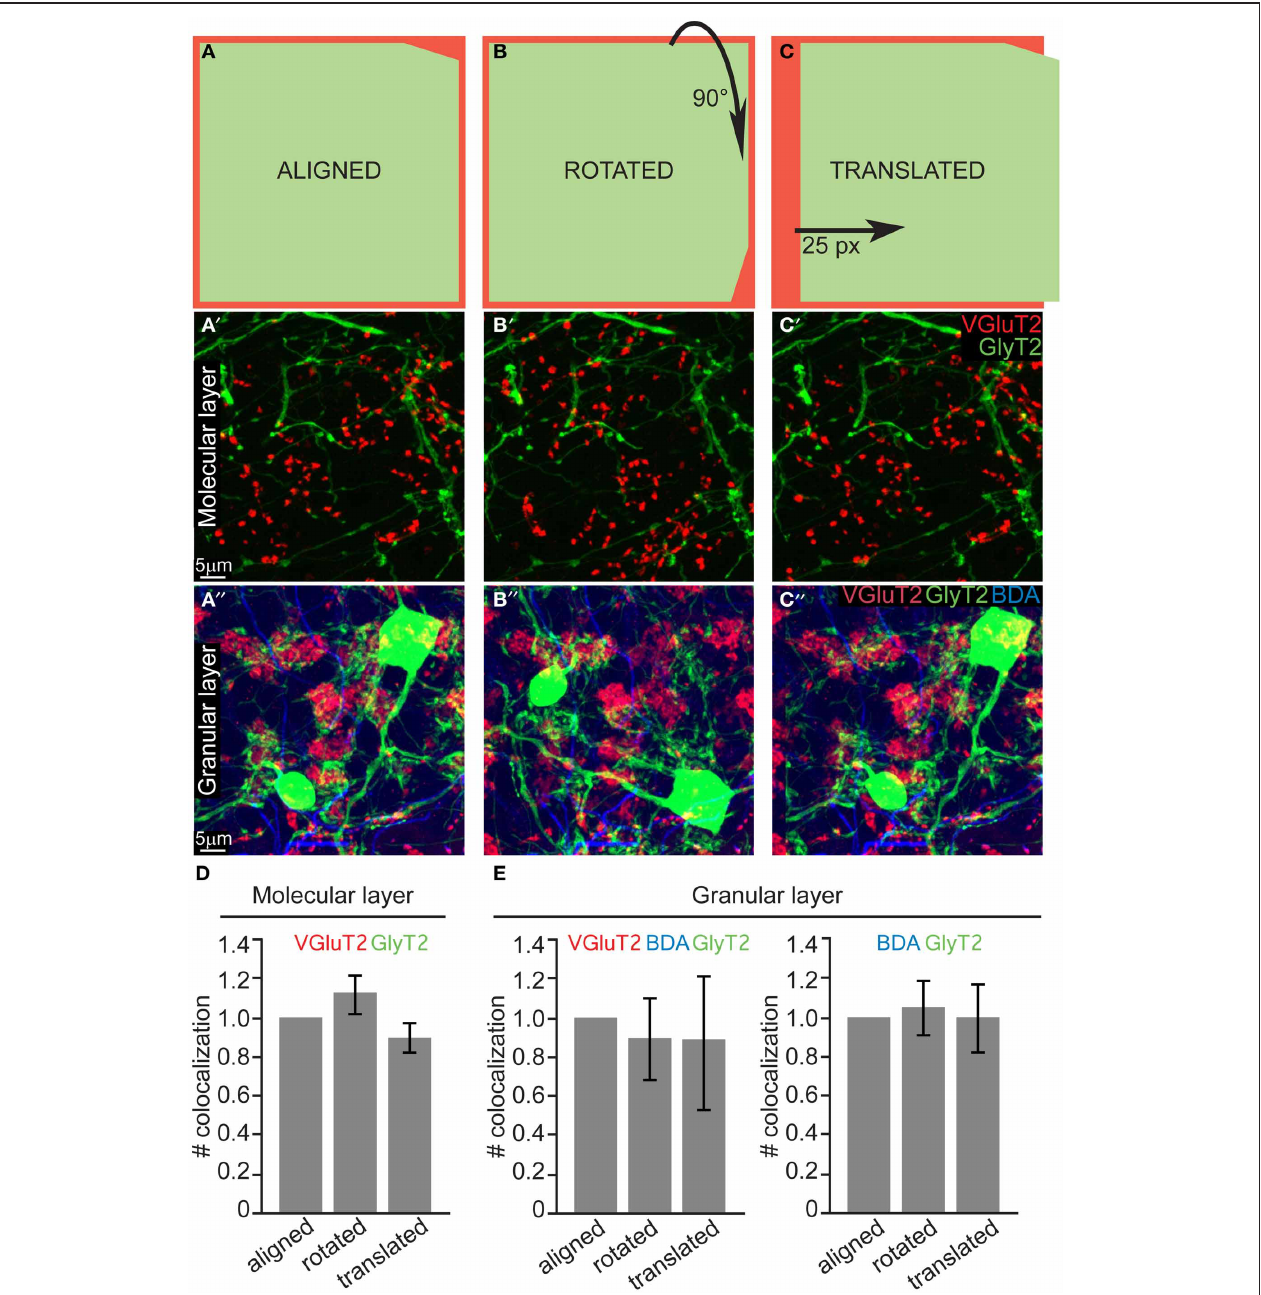
FIGURE 4 | Quantification of potential colocalization in thick slices also returns a negative result. (A) Schematic drawing of the “aligned” configuration, and examples of maximum intensity projections of 10 µ m slices from both the ML and GL ( A’ and A” , respectively). (B–B”) Same as (A–A”) for the “rotated” configuration, in which one channel was rotated 90 ◦ clockwise. (C–C”) Same as (A–A”) for the “translated” configuration in which one